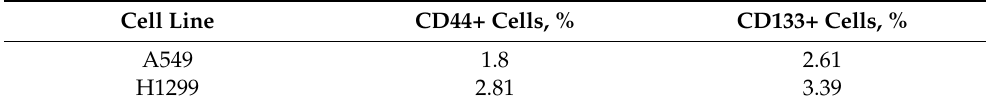
Figure 1. Gating strategy and representative images of CD44 − , CD44+, CD133 − and CD133+ popu- lations of A549 ( a ) and H1299 ( b ) cells using Amnis ImageStreamX Mk II Imaging Flow Cytometer. The first column represents bivariate plot of BF aspect ratio versus BF area, which allows for the selection of single cells and the removal of doublets and small and large debris. Histograms of CD44 and CD133 intensity in the second column allows for the selection of CD44+ and CD133+ cells (third column) from dimly stained (CD44 − and CD133 − ) events (fourth column). Table 1. The Percentage of CD44+ and CD133+ Cells in A549 and H1299